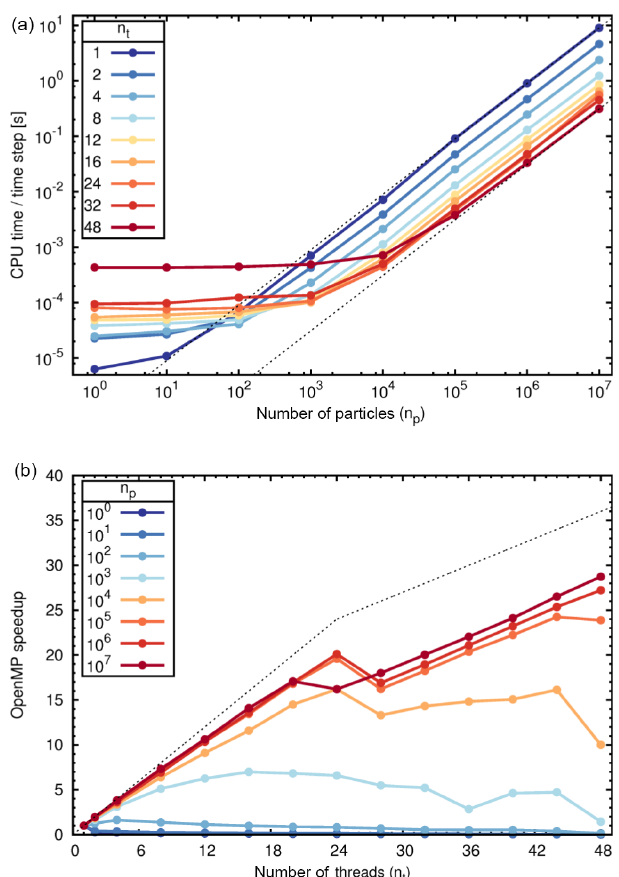
Figure 7. Scaling behavior in terms of CPU time (a) and speedup of the code (b) used to calculate trajectories with the midpoint method and a time step of 120s for different numbers of particles ( n p ) and OpenMP threads ( n t ). Colored curves refer to different numbers of OpenMP threads (a) or different total numbers of particles (b) . Dot- ted lines show ideal scaling